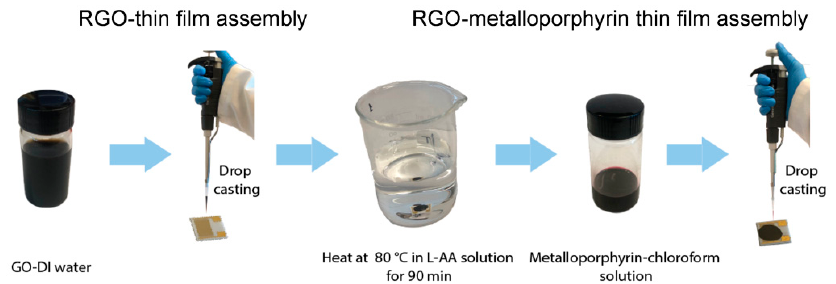
Figure 1. The fabrication process of an RGO–metalloporphyrin thin film is illustrated.